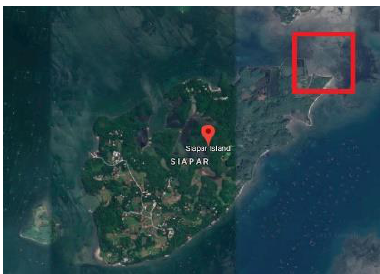
Figure 1: Area of study in Siapar Island as highlighted by the red box (Google Maps, 2019)